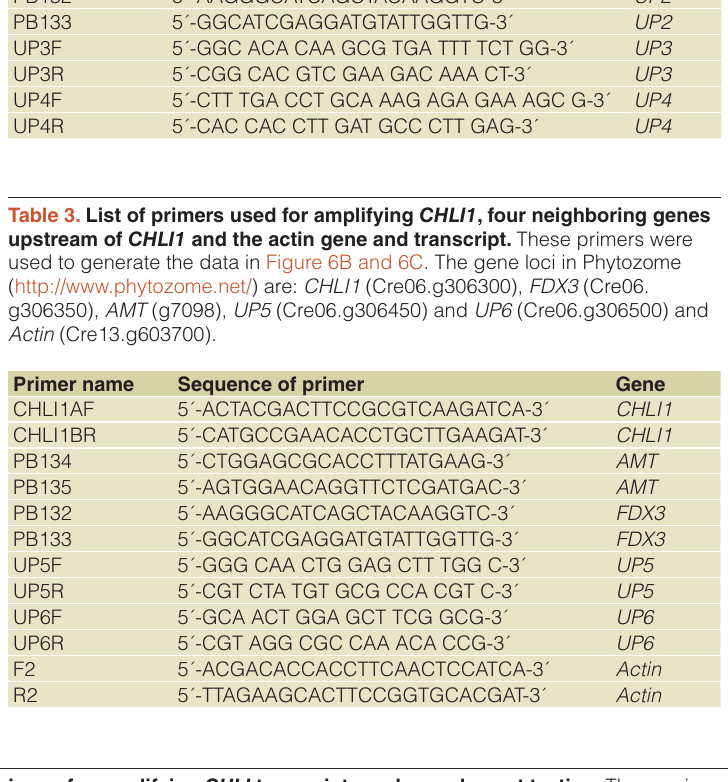
Table 4. List of primers for amplifying CHLI transcripts and complement testing. These primers were used in the experiments that generated the data in Figure 7 and Figure 10 and also used for CHLI1 cDNA amplification for